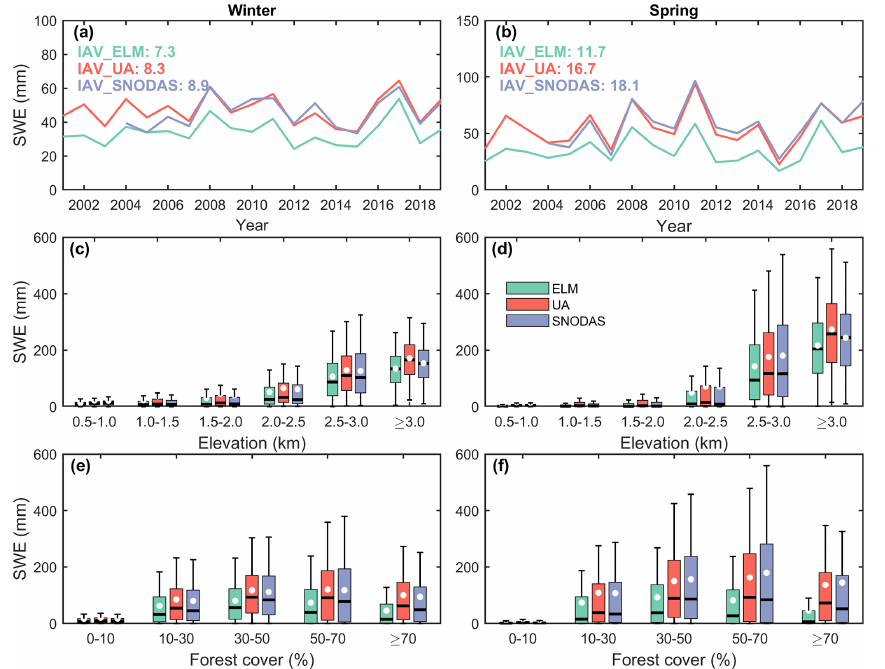
Figure 13. (a, b) Time series of regional average values, (c, d) elevation gradients, and (e, f) change with forest cover of snow water equivalent (SWE) in ELM (green), UA (red), and SNODAS (blue) over the WUS. Panels (a, c, e) are for winter, and panels (b, d, f) are for spring. In panels (c) – (f) , the white dots represent the average values.